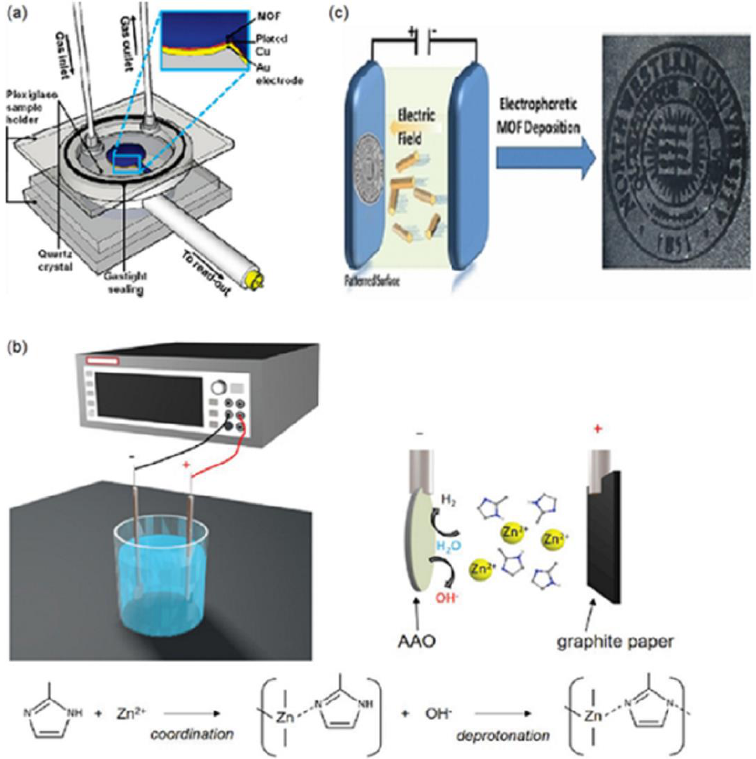
Figure 6. Illustration of electrodeposition of MOF membranes: ( a ) anodic deposition of [Cu 3 (BTC) 2 ] membrane, ( b ) cathodic deposition of ZIF − 8 membrane and ( c ) electrophoretic deposition of MOF membranes. Reprinted with permissions from Refs. [102,105,115].